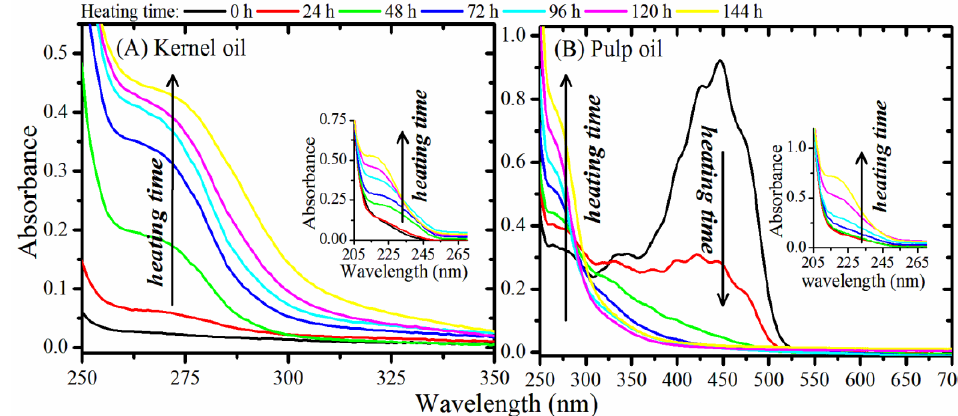
Figure 3. UV-Vis absorption spectra of the ( A ) kernel oil and ( B ) pulp oil as a function of heating time when diluted in hexane at 0.75% w / v . Inset: (A) kernel and (B) pulp oil absorption in the 200–270 nm range when diluted in hexane at 0.04% w / v . The arrows indicate the spectral response with the increase in time.